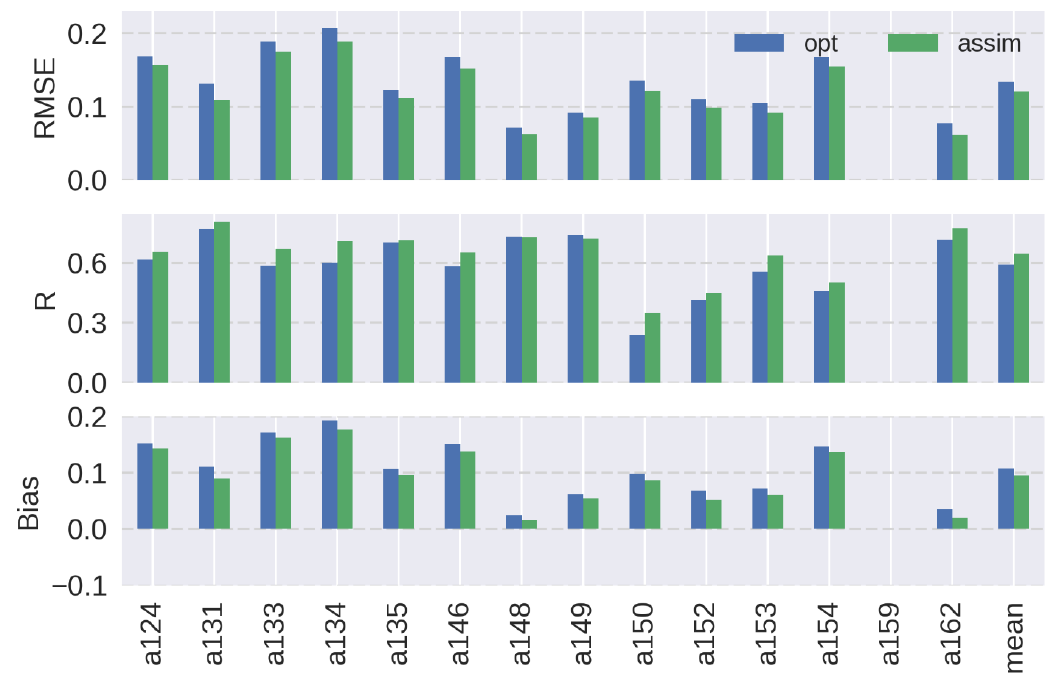
Figure 9. As in Figure 8 but for the simulation starting on 25 February 2007. Note that observation was not available at a159 during this simulation period.